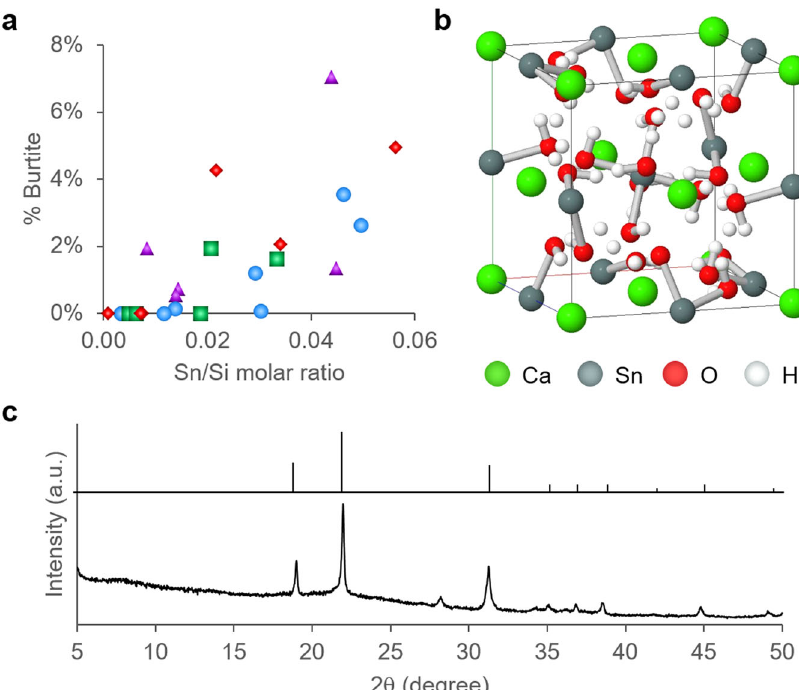
Fig. 3 Effect of Sn. a Graphical relationship illustrating the positive correlation between the weight fraction of burtite in products of eLAW zeolite synthesis series and the amount of tin in the growth mixture. Refer to the legend in Fig. 2b for symbol descriptions. b Burtite crystal structure, obtained from the Hudson Institute of Mineralogy using dat from ref. 43 . c PXRD pattern of burtite (bottom) synthesized by aging zeolite growth mixture eLAW-24, which had the highest Sn/Si molar ratio (Supplementary Table 2), for 24 h at room temperature without hydrothermal treatment. Reference pattern for burtite (top) was obtained from the American Mineralogist Crystal Structure